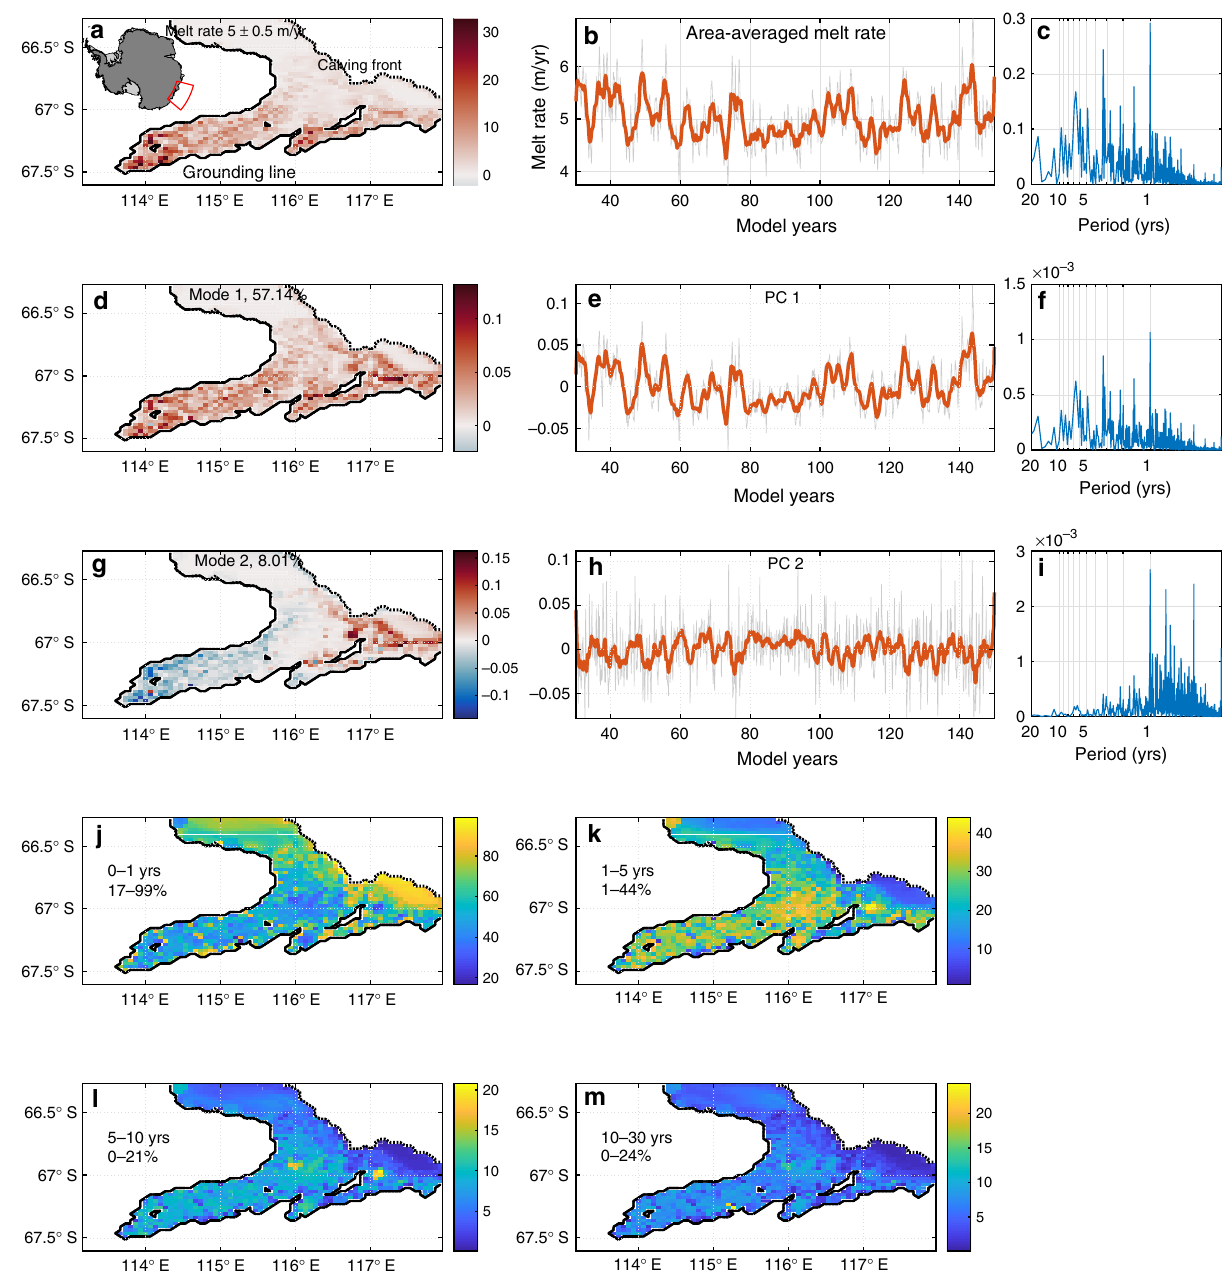
Fig. 3 Intrinsic variability in basal melting. a Average melt rate (5.0 m yr − 1 with standard deviation of 0.5 m yr − 1 ) and b area-averaged melt rate for the Totten Ice Shelf. The fi rst 30 years is considered model spin-up and is excluded from analysis. c Spectral variance (power spectrum times frequency) for the melt rate anomaly, constructed by removing the climatology. d Melt rate EOF mode 1 and e PC 1. f Spectral variance for melt EOF mode 1. g Melt EOF mode 2 and h PC 2. i Spectral variance for melt EOF mode 2. j – m SSA in-band % explained variance in melt rate, with band duration (years) and min – max variance shown. Inset in a shows location. Orange line in b , e , h is smoothed with a 1.5-yr fi lter, while grey line is raw data. Colour bars in j – m are scaled to the min/max variance range, as given as percentages on the left side of each